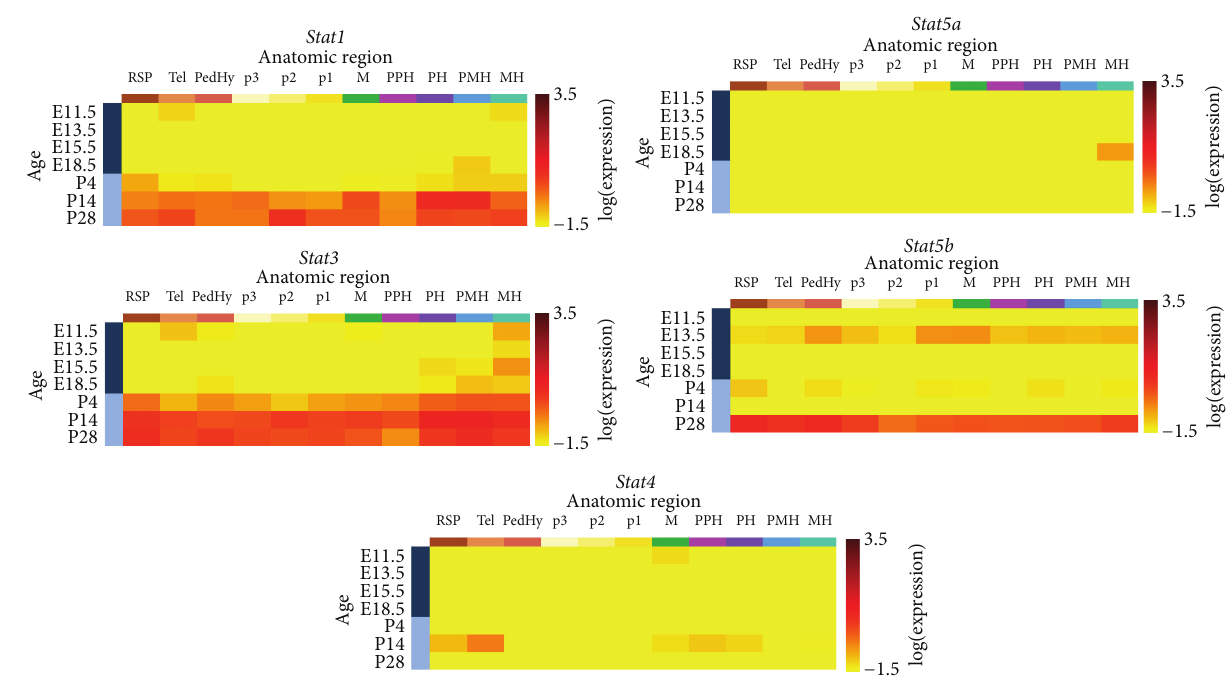
Figure 2: Stat ( Stat1 , Stat3 , Stat4 , Stat5a , and Stat5b ) gene expression in C57BL/6J mouse whole brain throughout development presented in each anatomical region with log ( expression ) . Jak gene expression data are not available. RSP: rostral secondary prosencephalon; Tel: telencephalic vesicle; PedHy: peduncular (caudal) hypothalamus; p3: prosomere 3; p2: prosomere 2; p1: prosomere 1; M: midbrain; PPH: prepontine hindbrain; PH: pontine hindbrain; PMH: pontomedullary hindbrain; MH: medullary hindbrain (medulla). Allen Developing Mouse Brain Atlas 2013